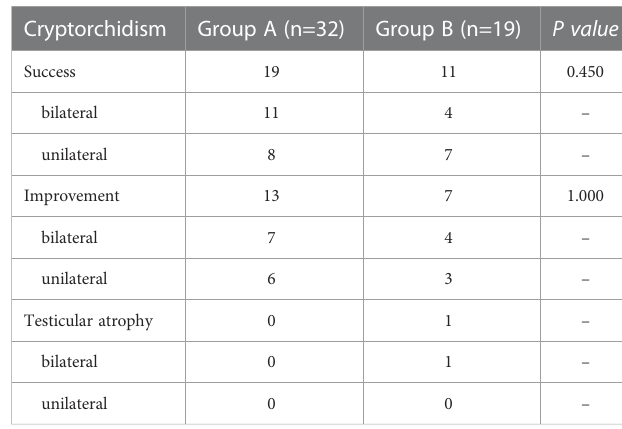
Tanner stage of pubic hair